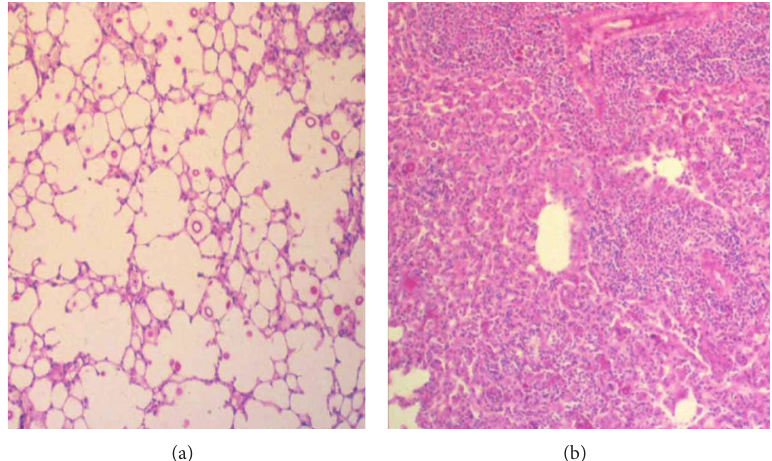
Figure 1: (a) The lung of mice infected with C. neoformans TIMM 0362 showed yeast cell proliferation in the alveoli but showed a very limited response of macrophage (13 days after infection, hematoxylin and eosin (HE) double stain, and original magnification × 200). (b) The lung of mice infected with C. neoformans TIMM 0372 showed numerous multinucleated giant cells (MGCs) due to the prominent macrophage response (13 days after infection, HE double stain, and original magnification ×